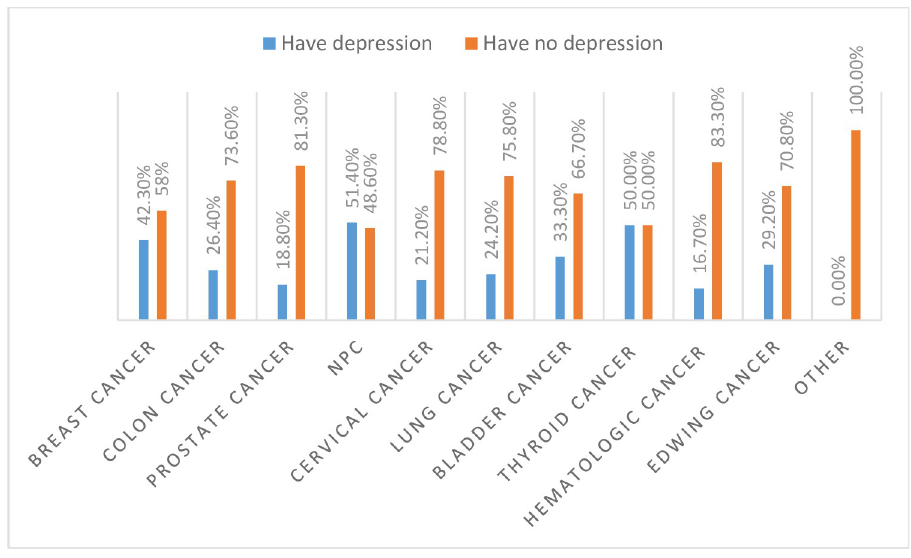
Fig 3. Depression among each type of